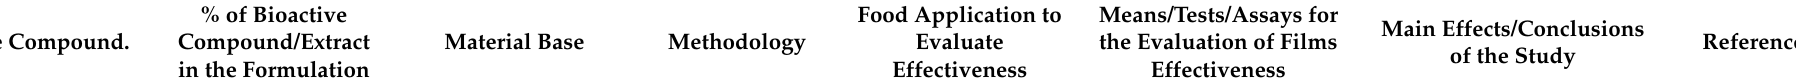
Table 3. Formulations and main effects of phenolic compounds incorporated in starch and gums edible films or coatings.